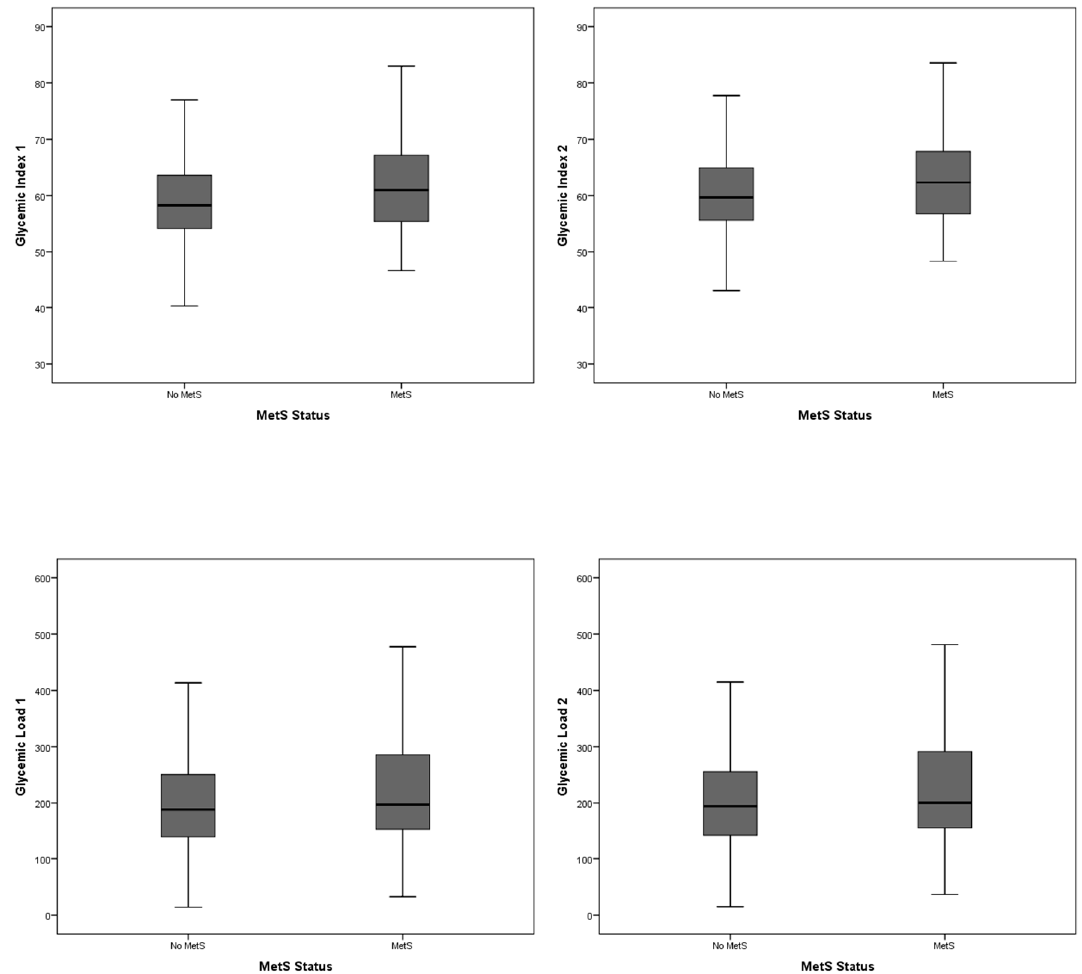
Figure 1. Box plot showing the distribution of dietary GI and GL among participants with and without MetS. GI: Glycemic index; GL: Glycemic load; MetS: Metabolic